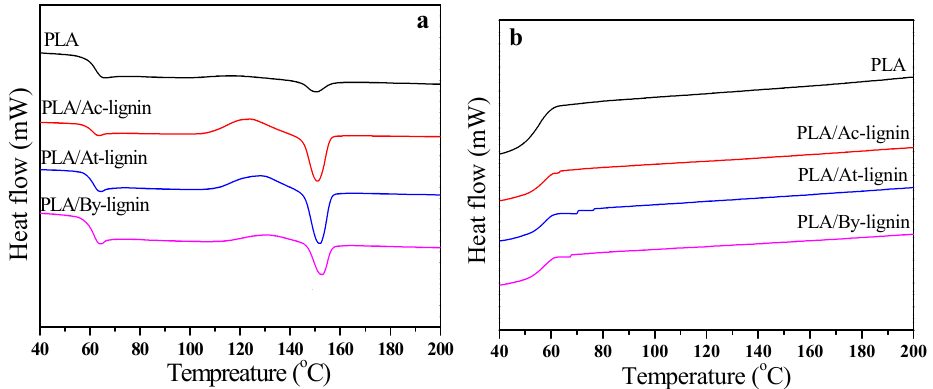
Figure 12. DSC thermograms of PLA and PLA/lignin biocomposites: ( a ) melting curves; ( b ) crystallization curves.